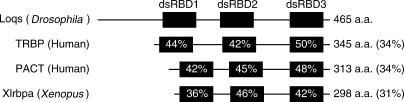
Domain Structure of Loqs and ItsHomo sapiens and Xenopus HomologsThe dsRNA-binding motif (dsRBD) is indicated as a black box. These proteins contain three putative dsRBDs. Loqs shares ∼34% amino acid identity with TRBP and PACT and ∼31% identity with Xlrbpa (Xenopus laevis RNA-binding protein A). Sequence comparison between Loqs and its human and Xenopus homologs also showed a higher degree of amino acid conservation in dsRBDs including C-terminal non-canonical dsRBDs. TheXenopus homolog, Xlrbpa, of TRBP/PACT has been found to associate with ribosomes in the cytoplasm [77], as is the case for many RNAi factors including miRNAs [47,78−82].